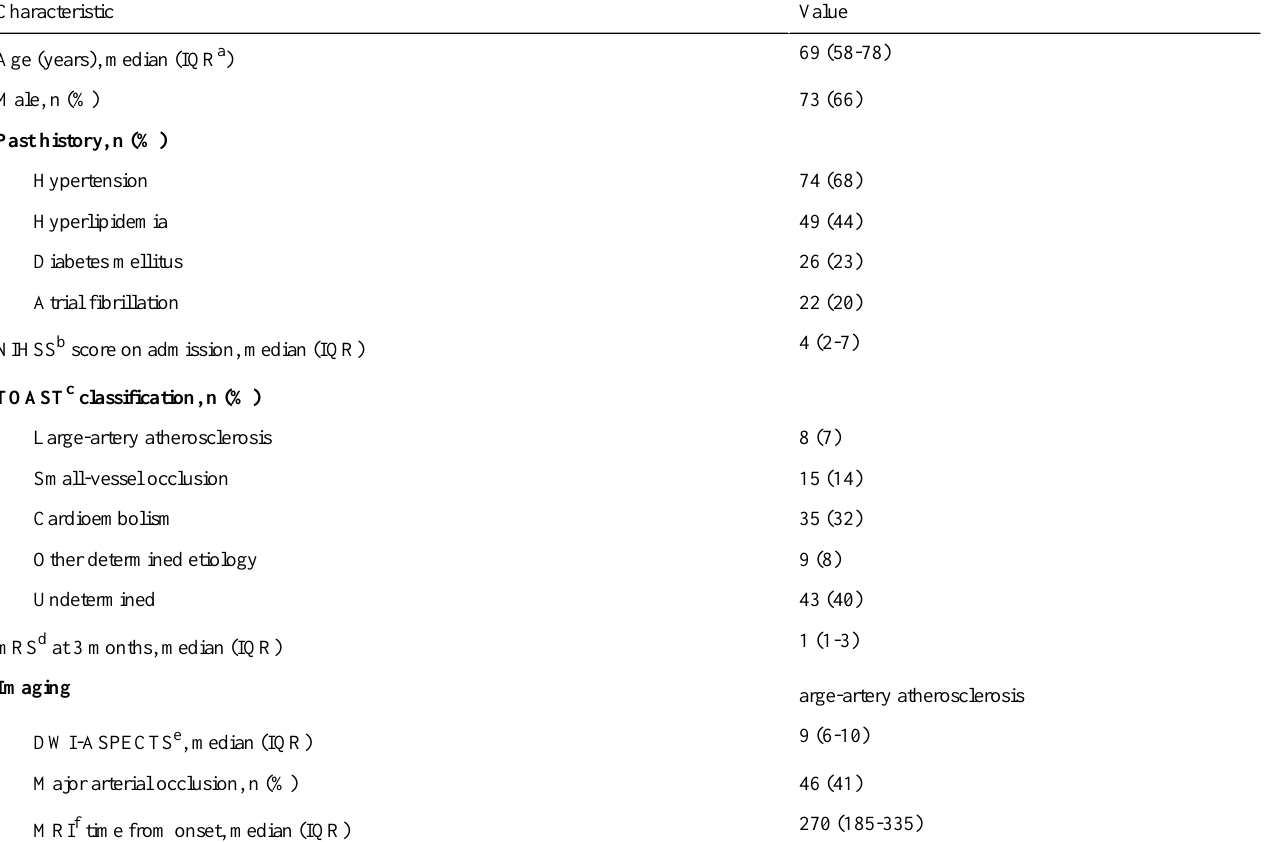
Table 1. Patient characteristics (n=111).